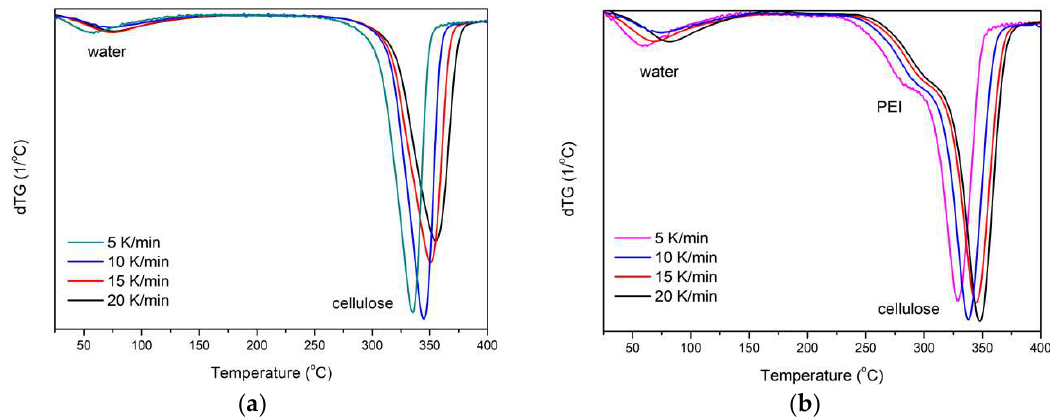
Figure 7. Results for cellulose fibers: ( a ) TG curve, ( b ) the DTG curve.